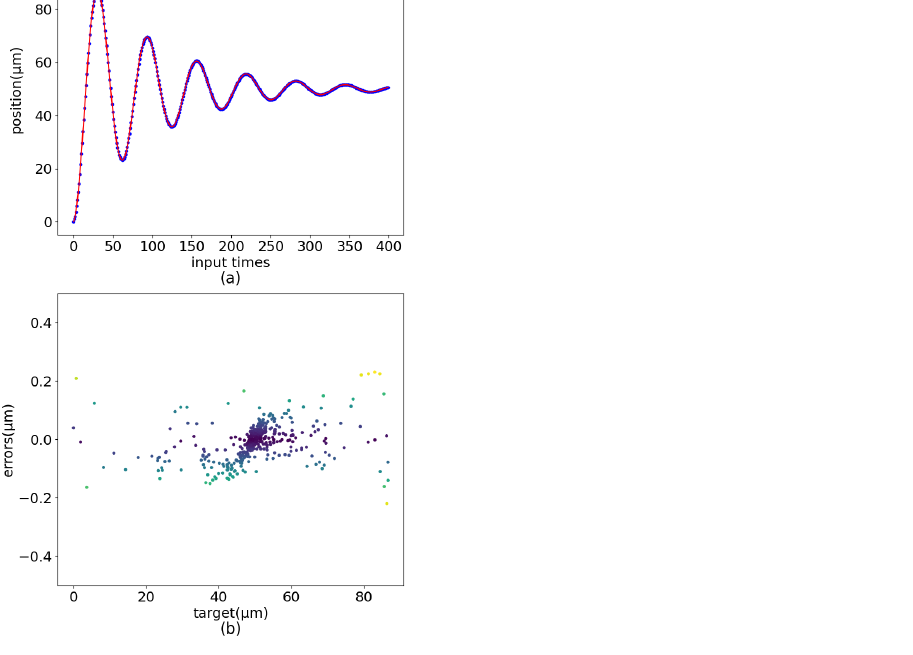
Figure 17. Dampened Sinusoidal motion control renderings. ( a ) Curve comparision. ( b ) Error